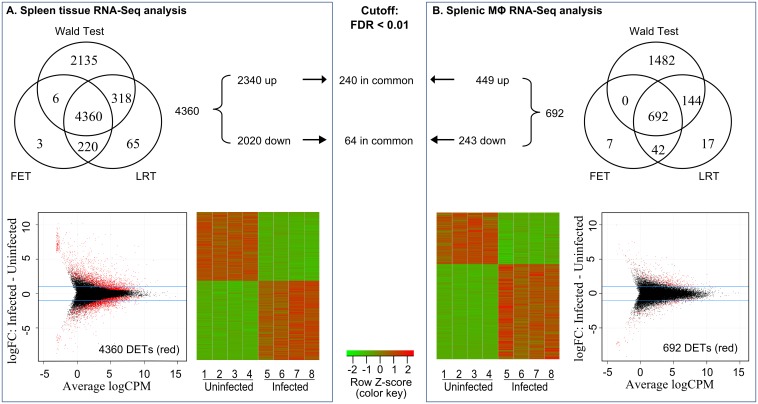
Identification of differentially expressed transcripts in spleen tissue and splenic macrophages in hamsters with VL.The number of differentially expressed transcripts in spleen (A) and splenic macrophages (B) from hamsters with VL determined by exact tests (FET) and generalized linear models with the likelihood ratio test (LRT) using the BioConductor R package EdgeR, and the Wald test in DESeq. A false discovery rate (FDR) <0.01 was used as the cutoff. Only transcripts with at least 1 count per million in at least 3 out of 4 samples in the control or experimental group were included in the analysis. A transcript was considered differentially expressed only when it was identified by all three different approaches. The lower panels show volcano plots and heat maps of the differentially expressed transcripts (DETs).